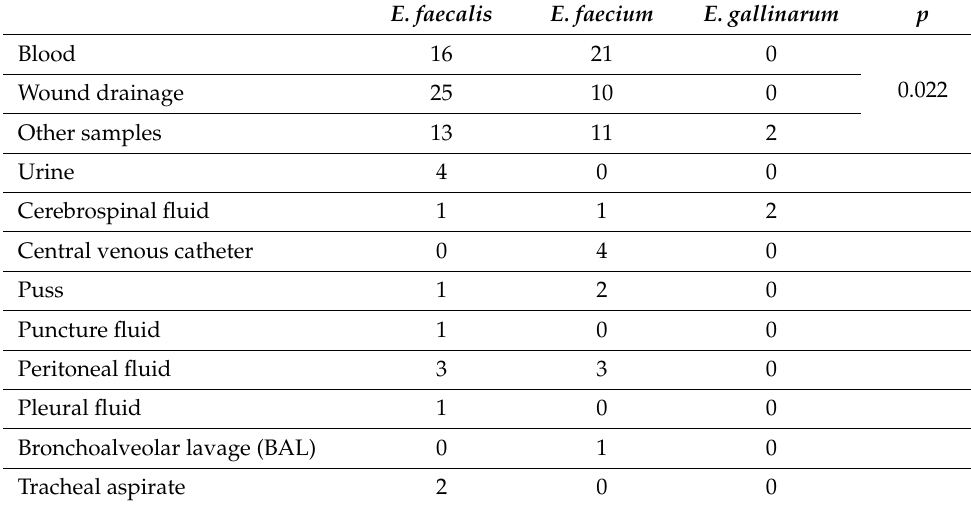
Table 2. Distribution of E. faecalis , E. faecium and E. gallinarum among the samples collected from